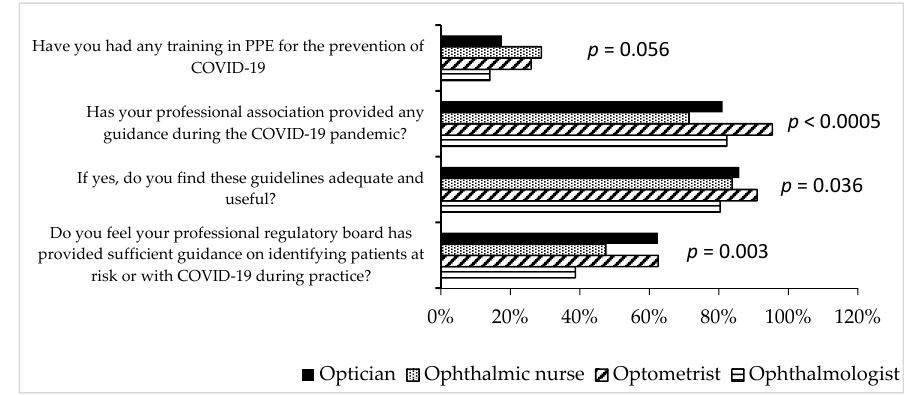
Figure 3. Practice of professional guidelines of respondents during the novel coronavirus disease 2019 (COVID-19) lockdown. PPE = Personal Protective Equipment.